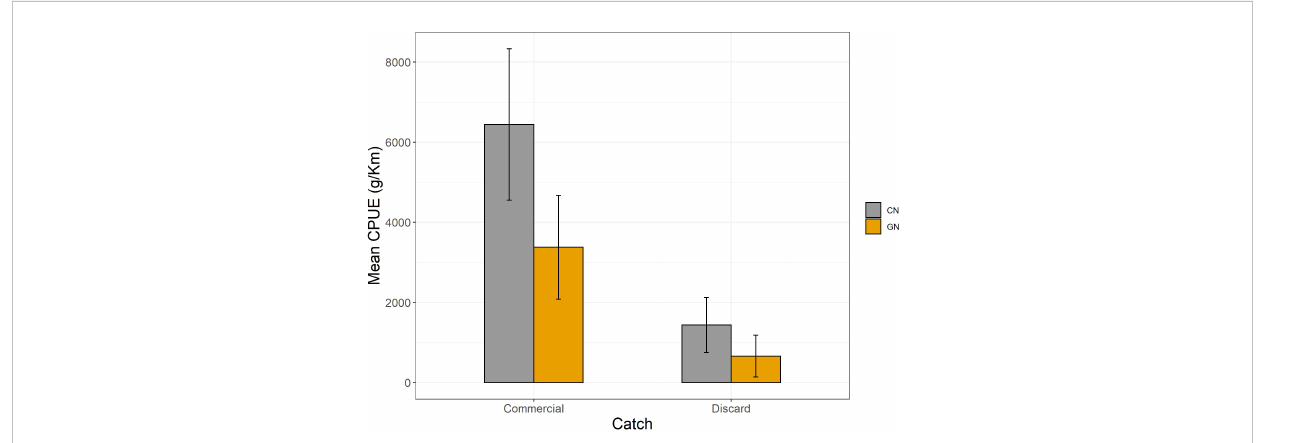
FIGURE 5 Mean catch per unit effort expressed as g/km for commercial and discarded catches per commercial (CN) and modi fi ed (GN) panel,